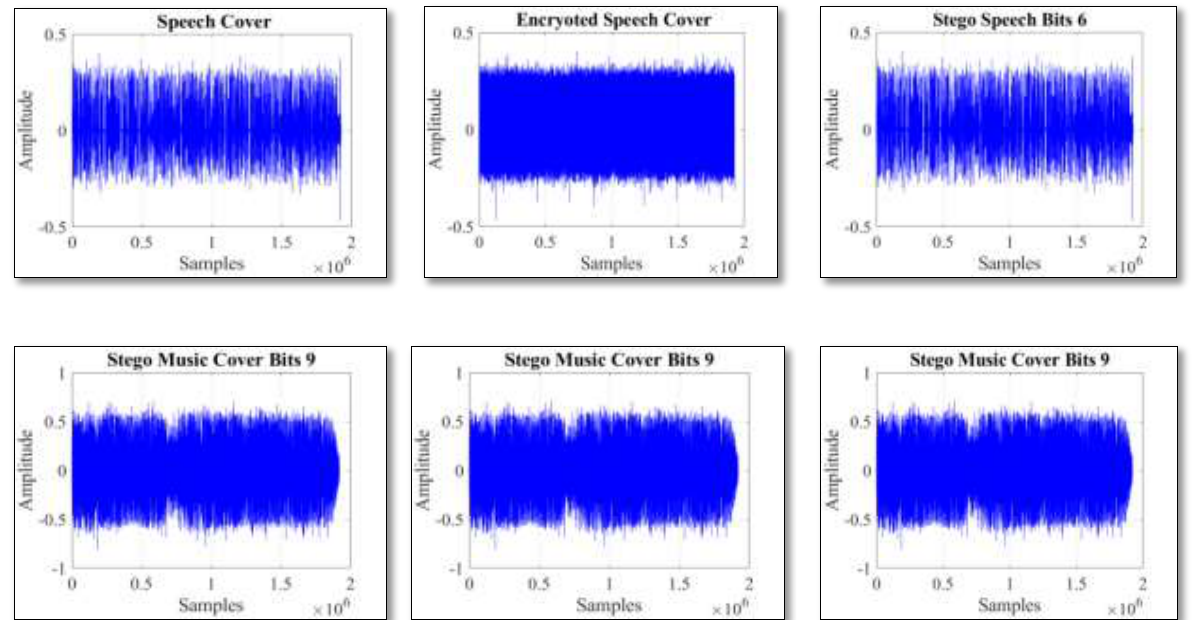
Fig.3: The original, encrypted and stego audio cover